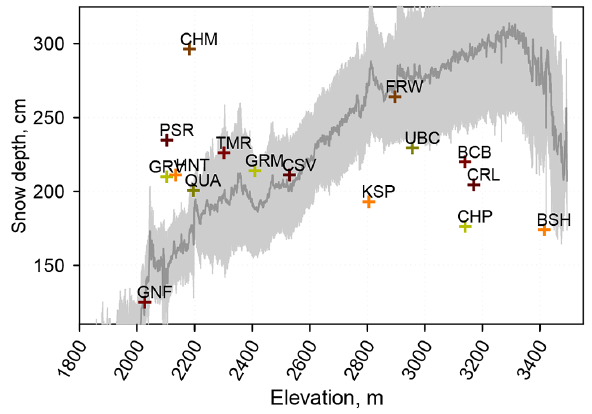
Figure 8. Observed snow depth on the 23 March LiDAR acquisi- tion date for all west-slope snow-pillow sites equipped with depth sensors, plotted over mean LiDAR snow depth (dark gray) and 1 standard deviation (light gray). Giant Forest (GNF), Farewell Gap (FRW) and Chagoopa Plateau (CHP) are within 21km of the measurement domain. Chilkoot Meadow (CHM) and Poison Ridge (PSR) are the sites furthest to the northwest. Locations shown in Fig. 1.